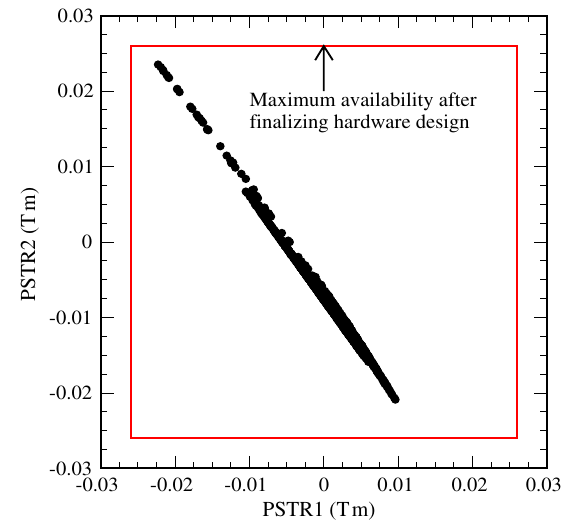
FIG. 6. Required magnetic fields of the PSTR magnets for a painting area of 100 (cid:1) mm mrad for the MR switching from a MLF painting area of 216 (cid:1) mm mrad based on the survey for all possible scenarios at the 400 MeV injection. The red box shows the maximum availability of final hardware designing based on the magnetic field measurement of the magnets. The corresponding maximum current for the pulse mode power supply is (cid:4) 450 A